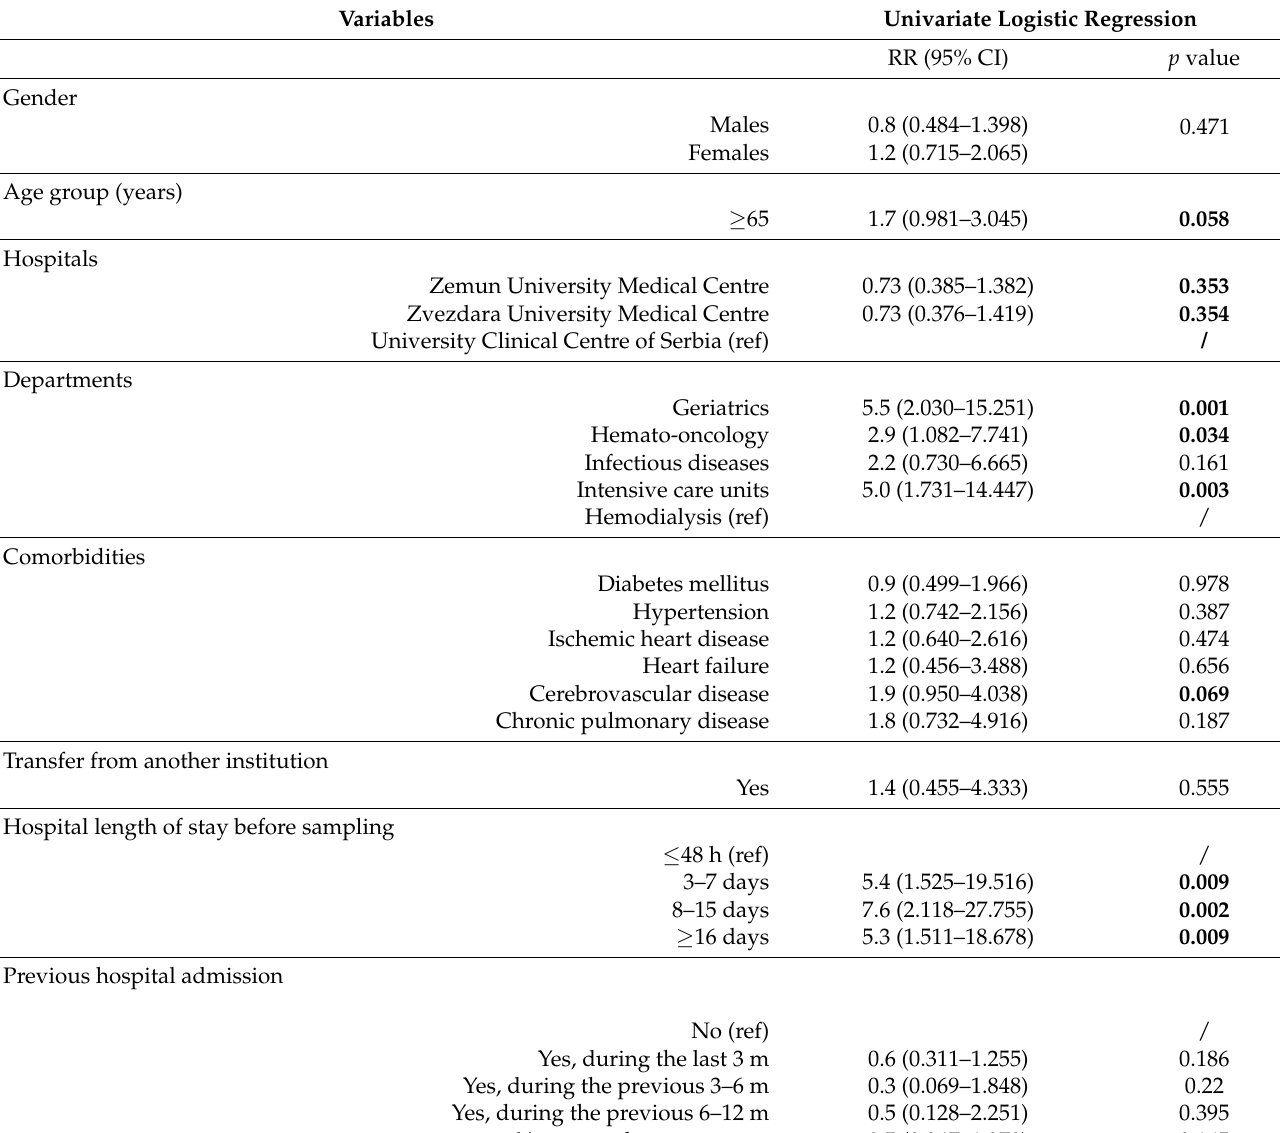
Table 2. Univariate logistic